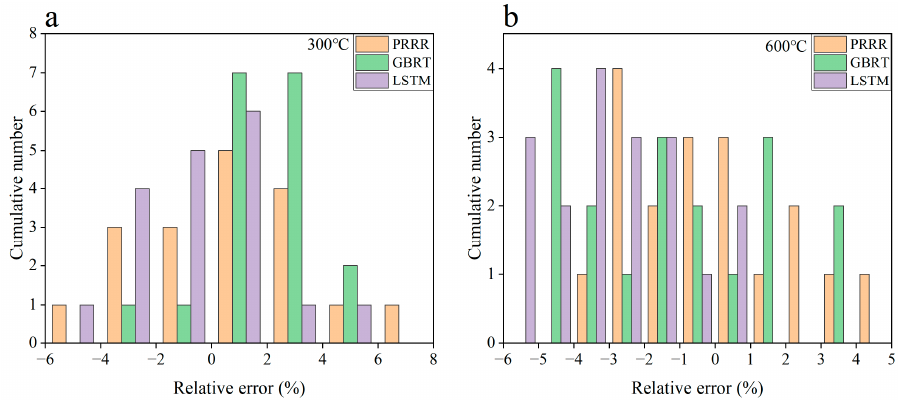
Figure 10. Relative errors of the predicted results to the experimental data for the different machine learning models in Figure 9. ( a ) 300 °C; ( b ) 600 °C. The range of relative errors is the same between the same numbers on the horizontal axis.